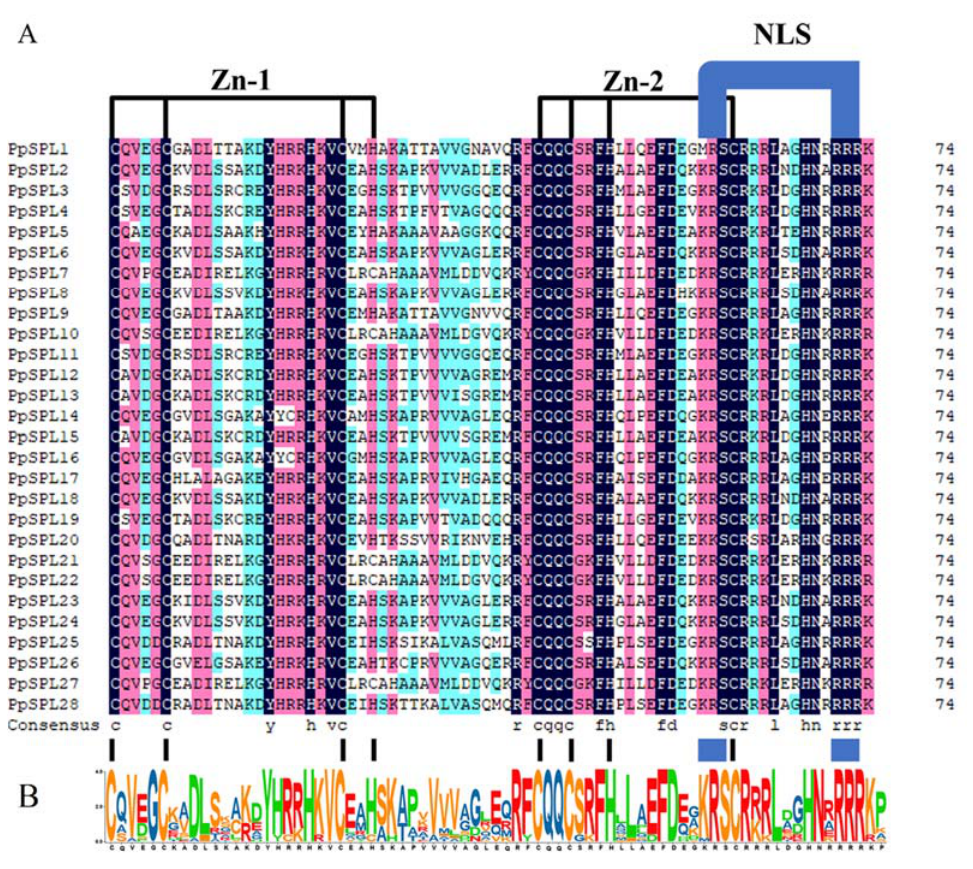
Figure 1. Alignment of SBP domains in PpSPLs . ( A ). Multiple alignment of conserved SBP domain, which contains two conserved zinc finger structures (Zn ‐ 1, Zn ‐ 2) and a nuclear localization signal which contains two conserved zinc finger structures (Zn-1, Zn-2) and a nuclear localization signal (NLS). ( B ). The sequence markers of conserved SBP domain in PpSPLs . (NLS). ( B ). The sequence markers of conserved SBP domain in PpSPLs